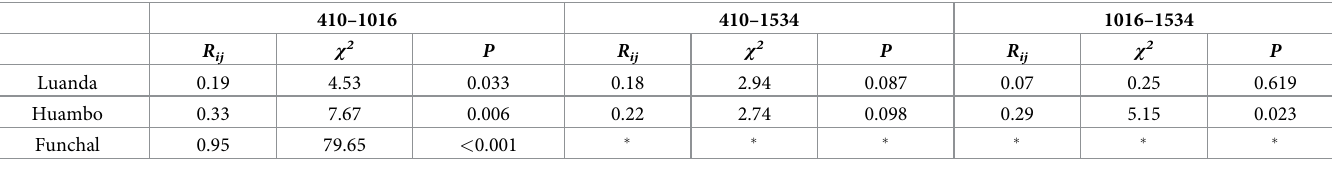
) and associated chi-squared tests between kdr mutations in Aedes aegypti ij